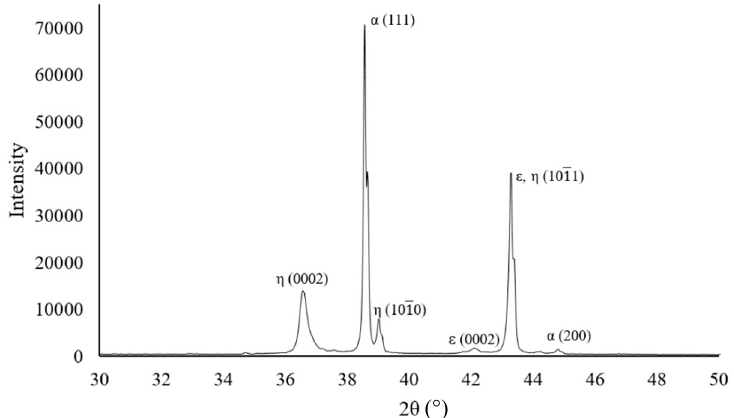
Figure 4. XRD pattern of as-cast solid ZA27 alloy.